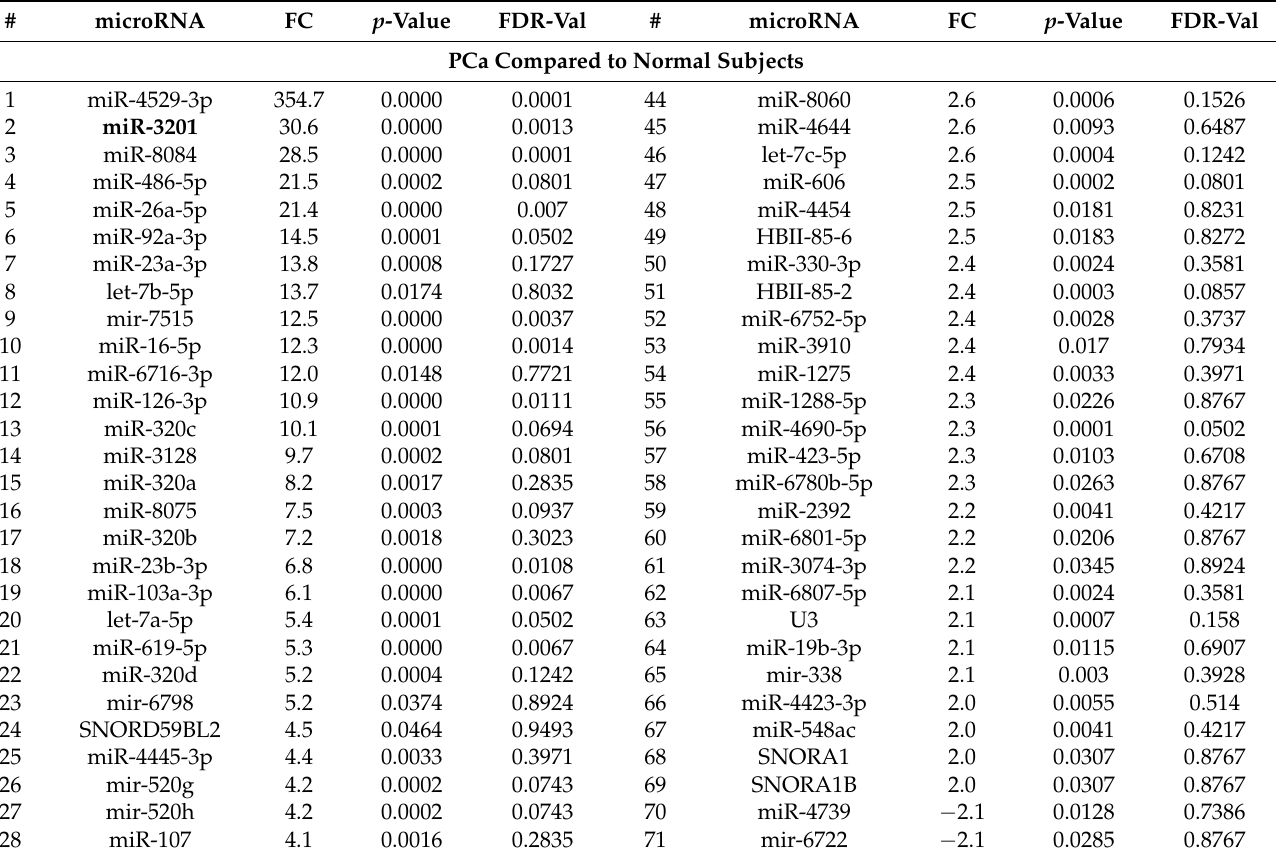
Table 1. miR profiling of small extracellular vesicles (sEVs) collected from plasma of PCa patients compared to normal individuals, AA compared to CA PCa and high Gleason score compared to low Gleason